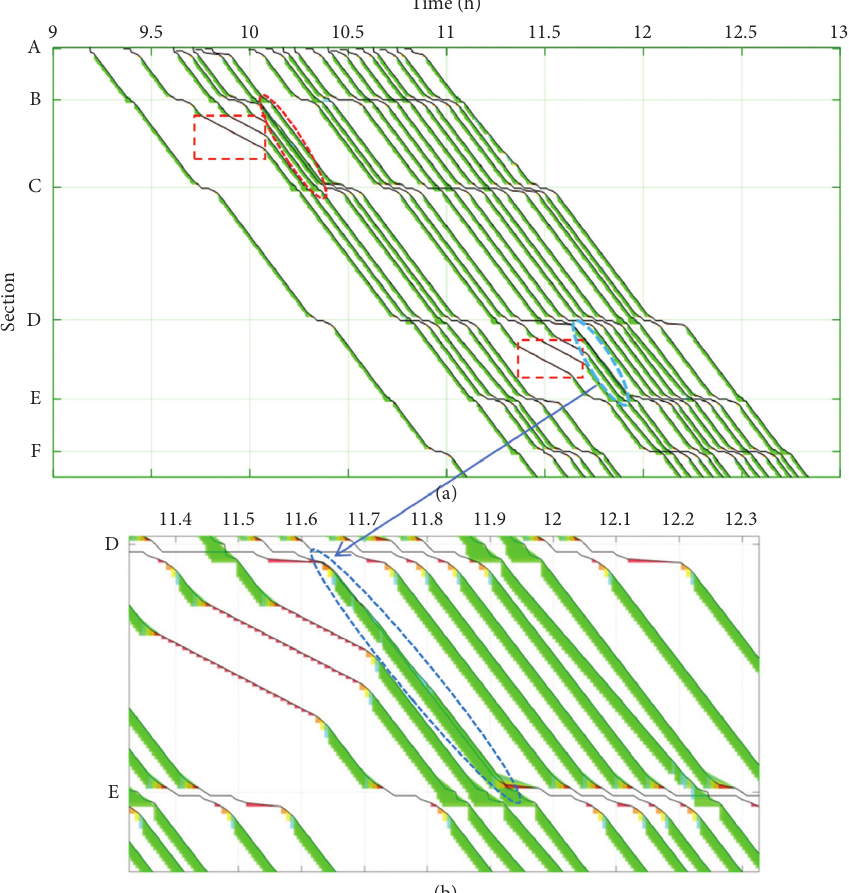
Figure 11: Rescheduled timetable after the first-step